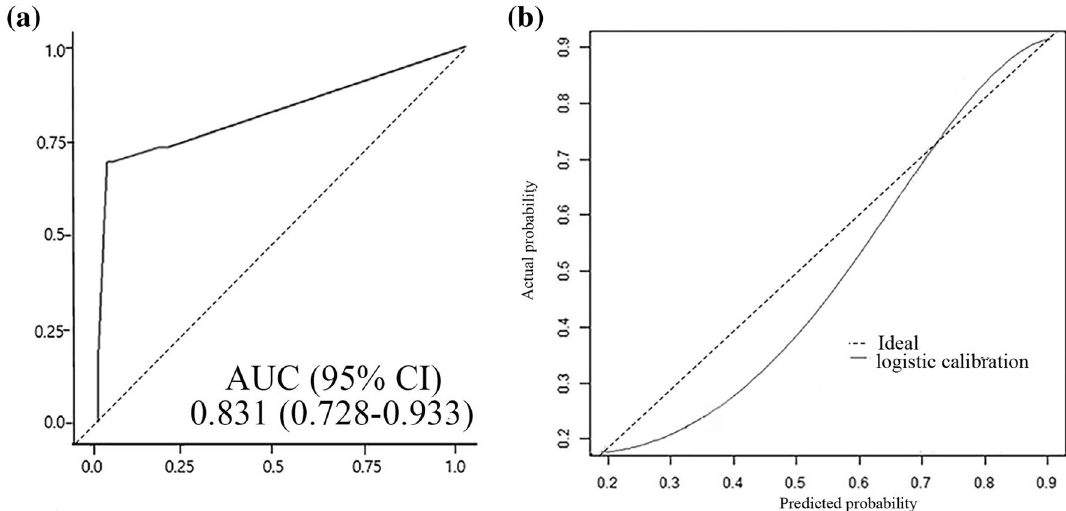
Figure 3. Validation of nomogram for predicting HFNC outcomes in patients with AHRF. ( a ) ROC curve of the nomogram with 114 patients in the validation cohort. ( b ) Calibration plot of the nomogram in the validation cohort. The black line indicates logistic calibration of the validation cohort. The x-axis is the predicted probability from nomogram, and the y-axis is the actual probability. The dashed line represents performance of the ideal nomogram (predicted outcome perfectly corresponds with actual outcome). ROC, receiver operating characteristic; HFNC, high flow nasal cannula; AHRF, acute hypoxemic respiratory